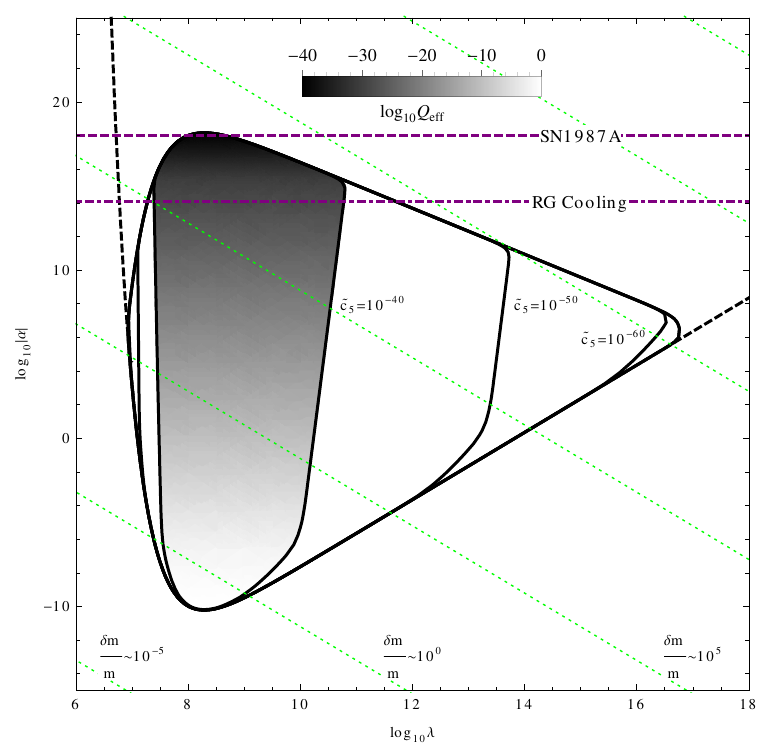
Figure 7 . Impact of a tree-level contribution ~ c 5 { M Pl to the quintic self-interaction on the anoma- lous lunar precession bound. As ~ c 5 is increased from 10 (cid:1) 60 and 10 (cid:1) 40 the constrained region shrinks because the onset of screening occurs at smaller and smaller (cid:11) c